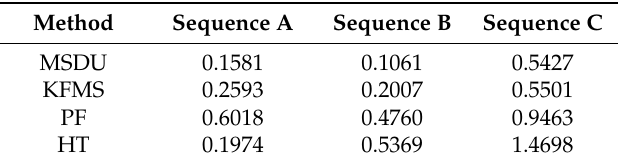
Table 4. Quantitative evaluation of moving target tracking by KFMS, PF, HT and MSDU. The values shown are the values of the average tracking error for each